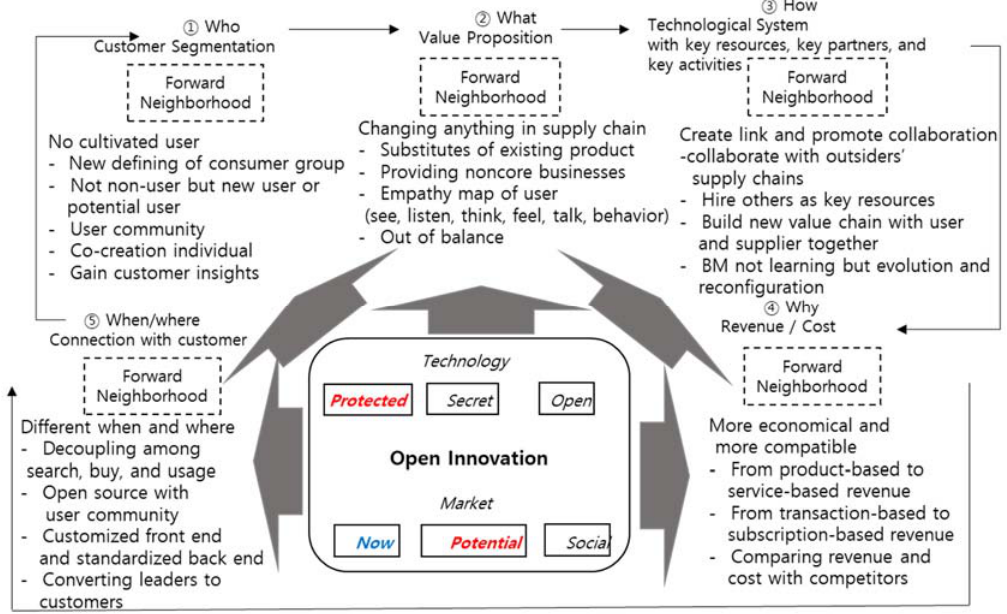
Figure 5. A cultivating forward neighborhood rectangular concept model for user-centered business model innovation.